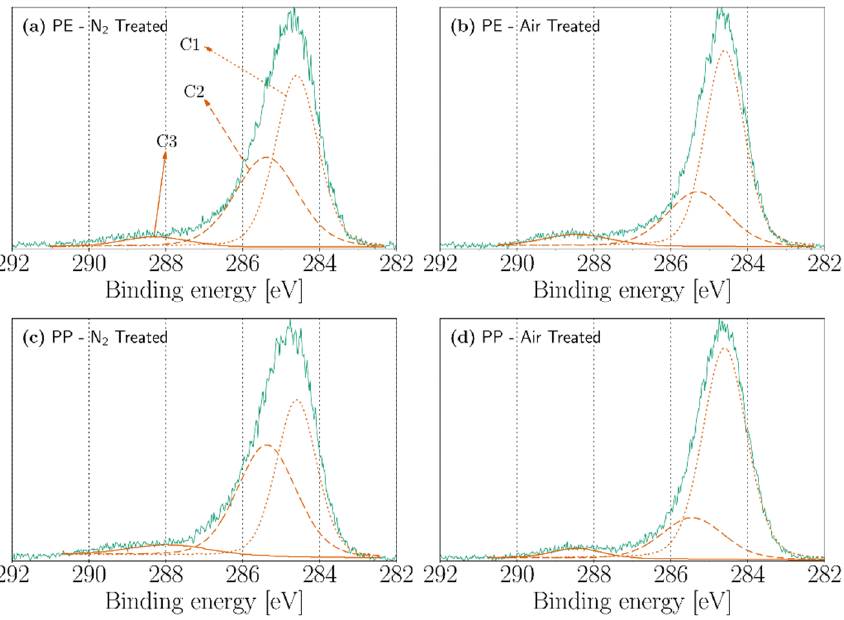
Figure 7. X-rayphotoelectronspectroscopy(XPS)high-resolutioncarbon(C1s)spectraof( a )nitrogen-treated Figure 7. X-ray photoelectron spectroscopy (XPS) high-resolution carbon (C1s) spectra of ( a ) nitrogen- PE, ( b ) air-treated PE, ( c ) nitrogen-treated PP, and ( d ) air-treated PP. treated PE, ( b ) air-treated PE, ( c ) nitrogen-treated PP, and ( d ) air-treated PP. Figure 7. X-ray photoelectron spectroscopy (XPS) high-resolution carbon (C1s) spectra of ( a ) nitrogen- Figure 7. X-ray photoelectron spectroscopy (XPS) high-resolution carbon (C1s) spectra of ( a ) nitrogen- Figure 7. X-ray photoelectron spectroscopy (XPS) high-resolution carbon (C1s) spectra of ( a ) nitrogen- treated PE, ( b ) air-treated PE, ( c ) nitrogen-treated PP, and ( d ) air-treated PP. treated PE, ( b ) air-treated PE, ( c ) nitrogen-treated PP, and ( d ) air-treated treated PE, ( b ) air-treated PE, ( c ) nitrogen-treated PP, and ( d ) air-treated PP.